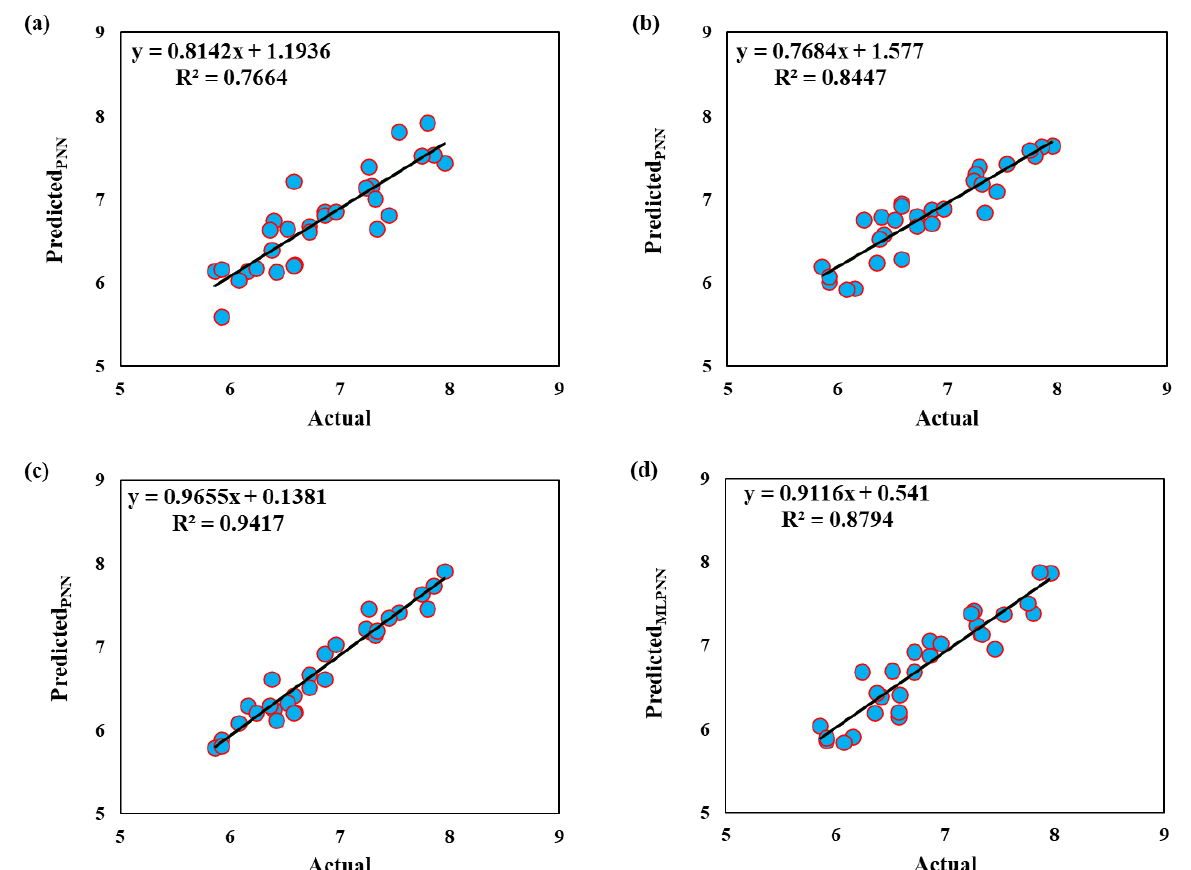
Figure 4. Scatter Plots for the PNN method: ( a ) Model-1; ( b ) Model-2; ( c ) Model-3; and ( d ) Model-4, respectively.